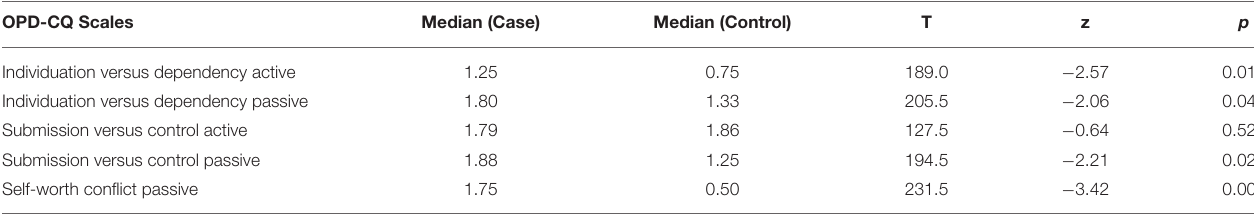
TABLE 6 | Comparison of OPD-CQ scores (wilcoxon test). OPD-CQ